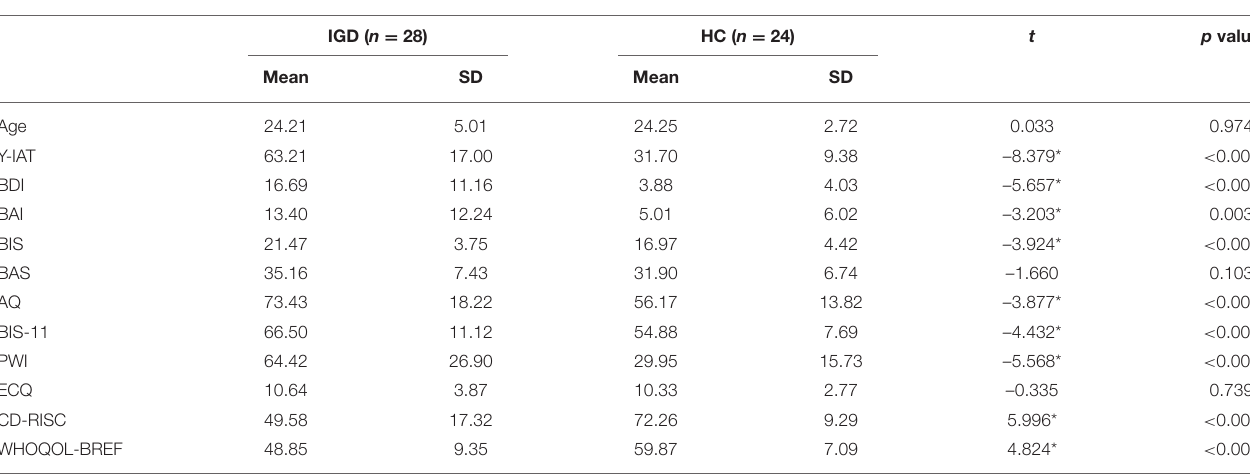
TABLE 1 | Demographic and clinical